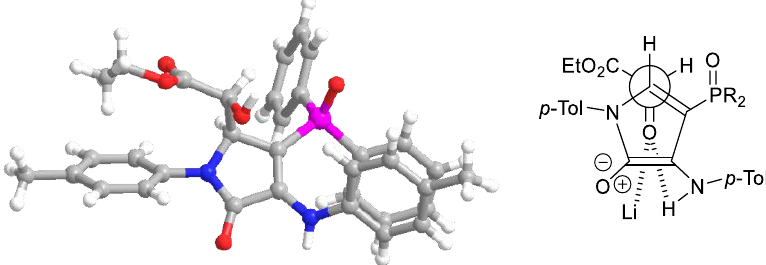
Figure 2. Plausible transition state for the nucleophilic addition to ethyl glyoxalate and X-ray structure of functionalized γ -lactam 12b (H, white; C, grey, O, red, N, blue, P, pink) ( R , R enantiomer shown). Surprisingly, under the same reaction conditions, for the special case of the nucleophilic addition of phosphorated γ -lactam 4d to p -nitrophenyl isocyanate, the introduction of an imine moiety into the five-membered ring was observed to give γ -lactam 13 (Scheme 5). typical nucleophilic addition to an isocyanate substrate. Then, a spontaneous oxidation of the 5-membered heterocycle is proposed to yield intermediate 15 . Next, an intramolecular membered aziridinone species 16 , and a subsequent rearrangement of the aziridinone and the enamine moieties at the γ -lactam core would lead to N -formamide 17 that undergoes a spontaneous cleavage of the formyl residue to afford imine-functionalized γ -lactam 13 .